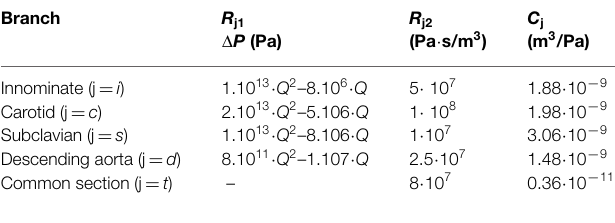
TABLE1 | Valueoftheparameterschosentocharacterizeeachdownstream branch j: non-linear resistances indicated through the pressure drop ( Δ P ) across the resistance R j1 (with Q indicating the volumetric flow-rate); linear resistances R j2 to account for the distributed resistances; compliances C j